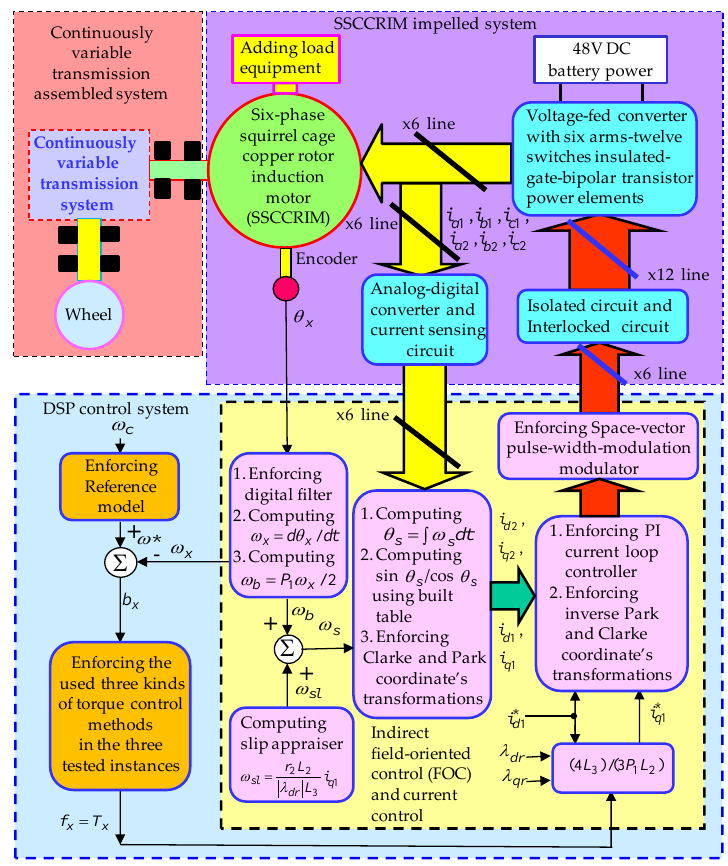
Figure 2. Composition of the SSCCRIM impelled continuously variable transmission assembled system.